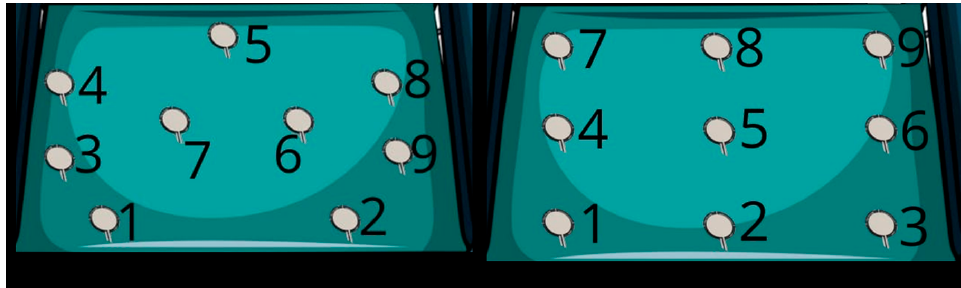
Figure 6. Left: Random configuration of FSR sensors, right: 3 × 3 Matrix configuration of FSR sensors.